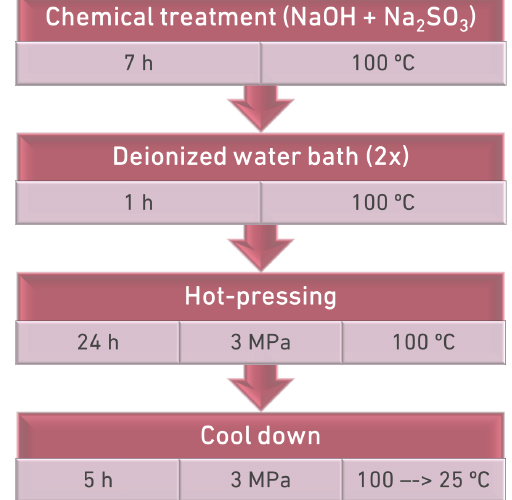
Figure 4. Steps of the densification process.